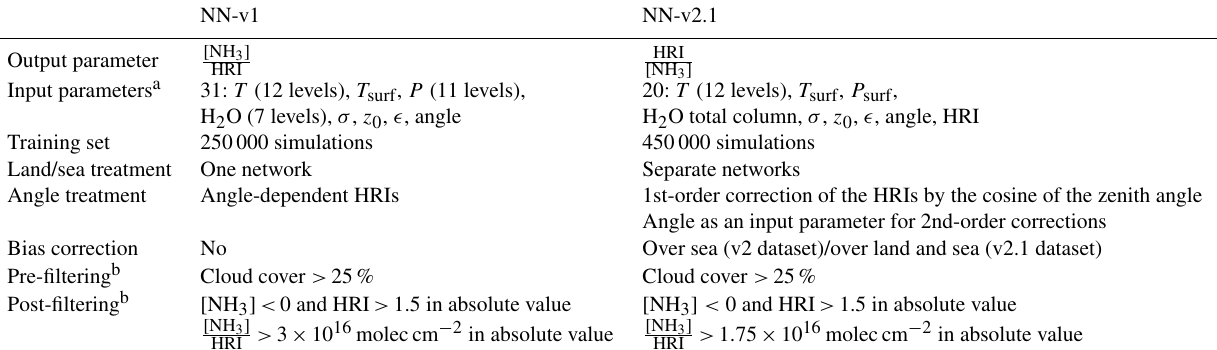
Table 1. List of changes from ANNI-NH 3 -v1 to ANNI-NH 3